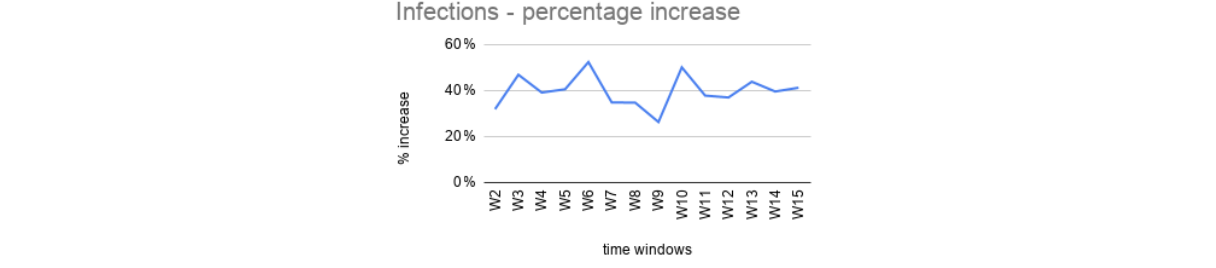
Figure 2. Percentage increase between the predicted and the observed number of infections. On the x-axis, we have time windows and, on the y-axis, the percentage increase of the predicted infection values with respect to the observed ones.